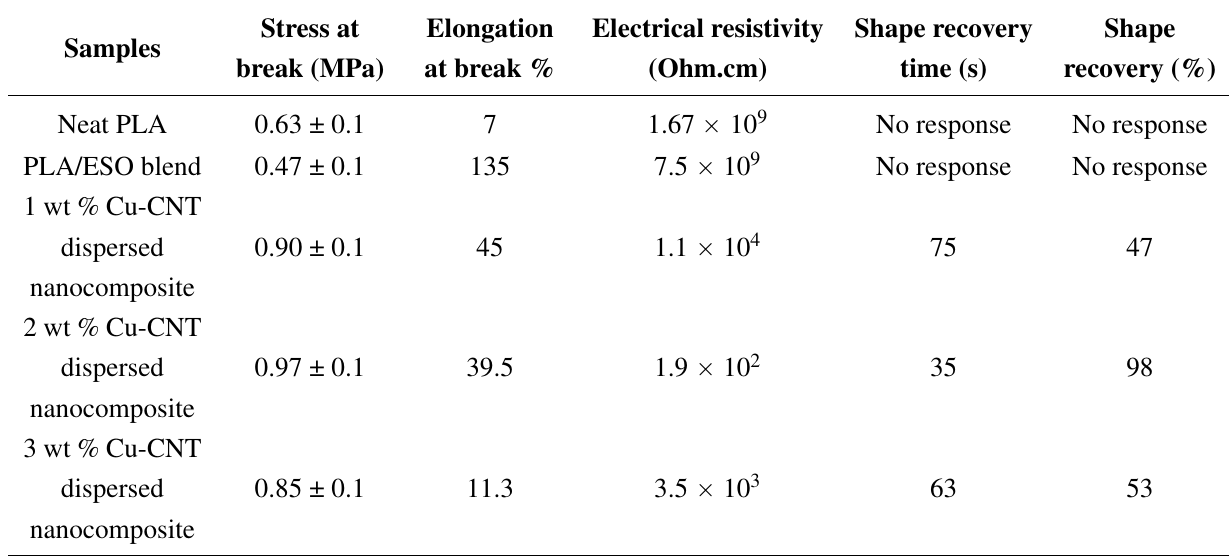
Figure 3. Electroactive shape recovery behaviour of the Cu-CNT dispersed PLA/ESO nanocomposite (Cu-CNTs content of 2 wt %) at a DC voltage of 40 V. Table 1. Mechanical, electrical, and electroactive shape memory properties of the as-prepared samples.